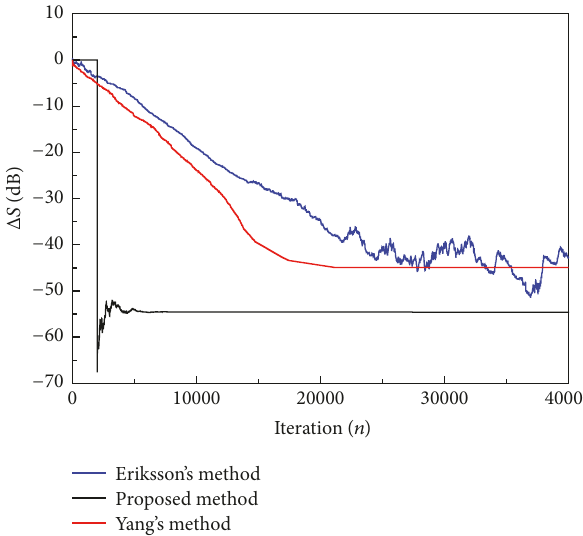
Figure 5: Performance comparison of error channel